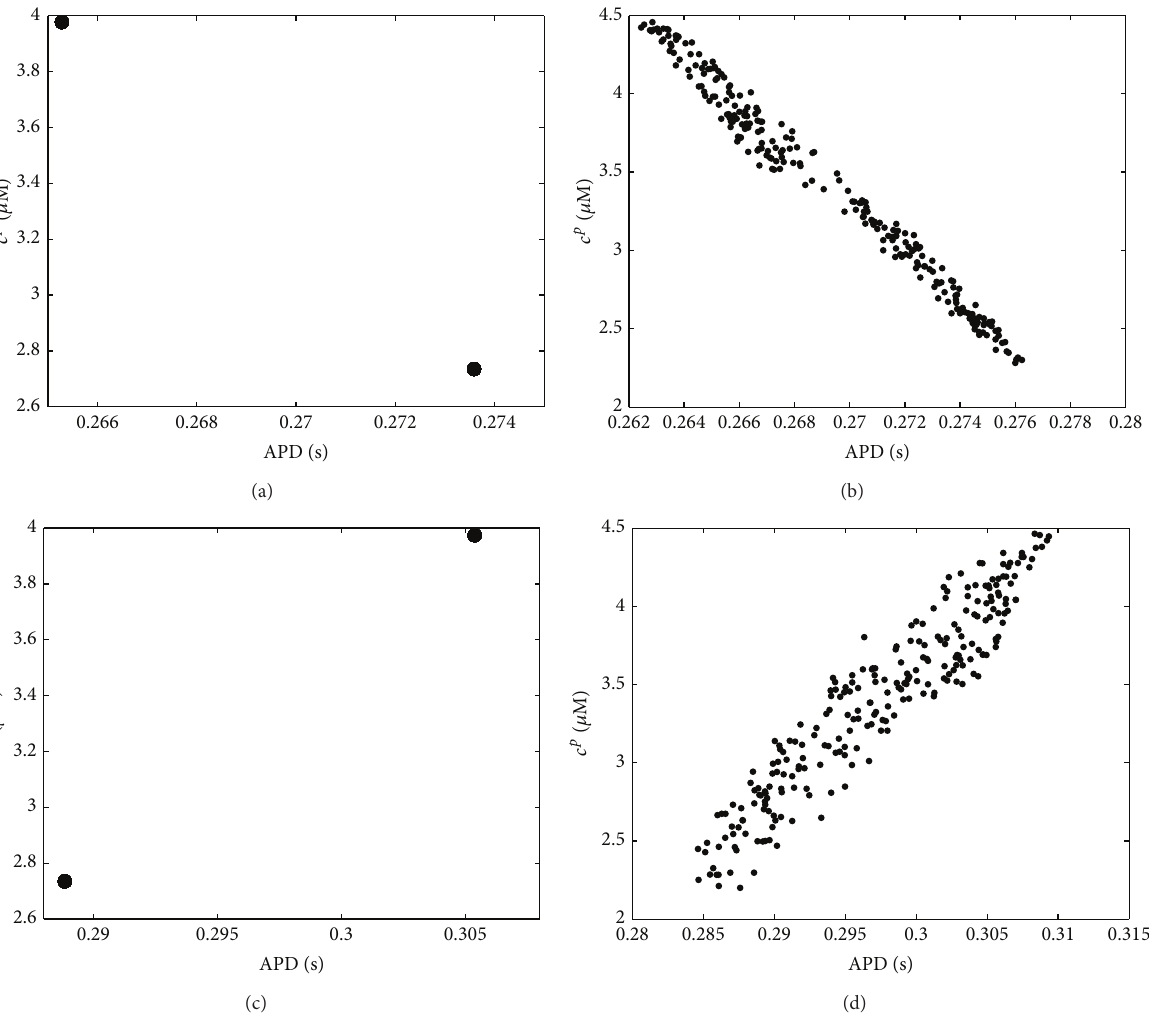
Figure 2: Plots of peak calcium 𝑐 𝑝 versus APD for the coupled system (10), with the same function 𝑔 in Figure 1, and 𝑓(𝐷 𝑛 ) = 0.2[1 − 1/(1 + ) = 1 − 0.5𝑒 −𝐷 𝑛 /0.02 at the parameters 𝑇 = 0.4, 𝛼 = 2, 𝑤 = 0.4 , and 𝑐 𝑒 (𝐷 𝑛 −0.02)/0.04 )] + 0.1𝑒 −(𝐷 𝑛 −0.06) 2 /0.8 , and 𝑞(𝐷 𝑛 (b) 𝜖 = 0.5 , under the other conditions same as in (a). (c) 𝜖 = 0 and 𝛾 = 0.02 . (d) 𝜖 = 0.5 , under the other conditions same as in